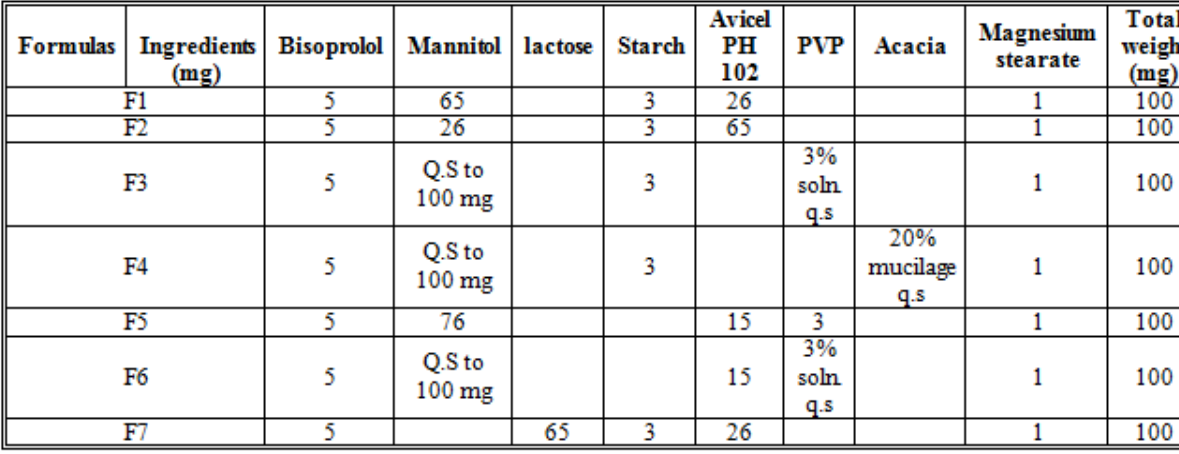
Table 1: Different formulas of Bisoprolol